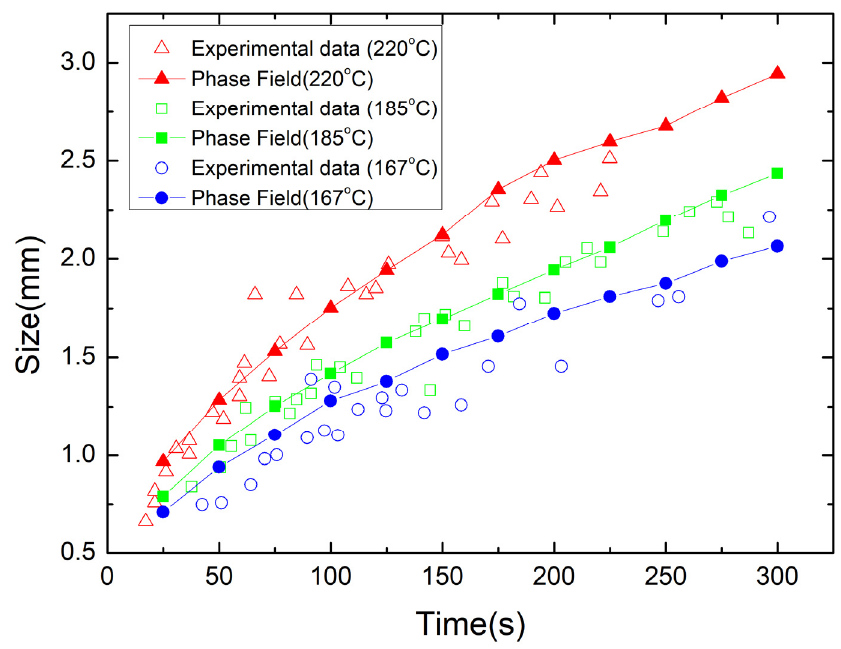
Figure 2. Comparison of simulated grain size to experimental data [34] in the isothermal grain growth process. growth